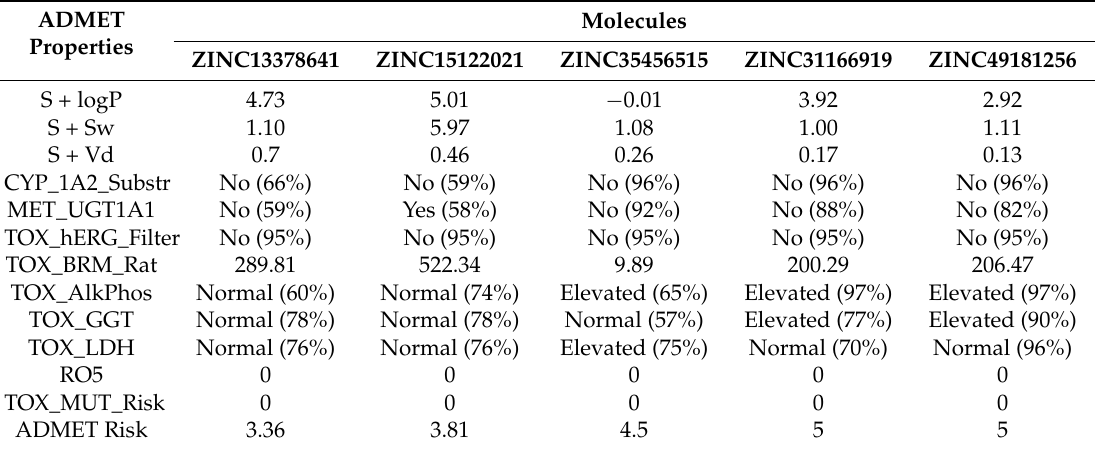
Table 2. The ADMET (absorption, distribution, metabolism, excretion and toxicity) properties of the top five